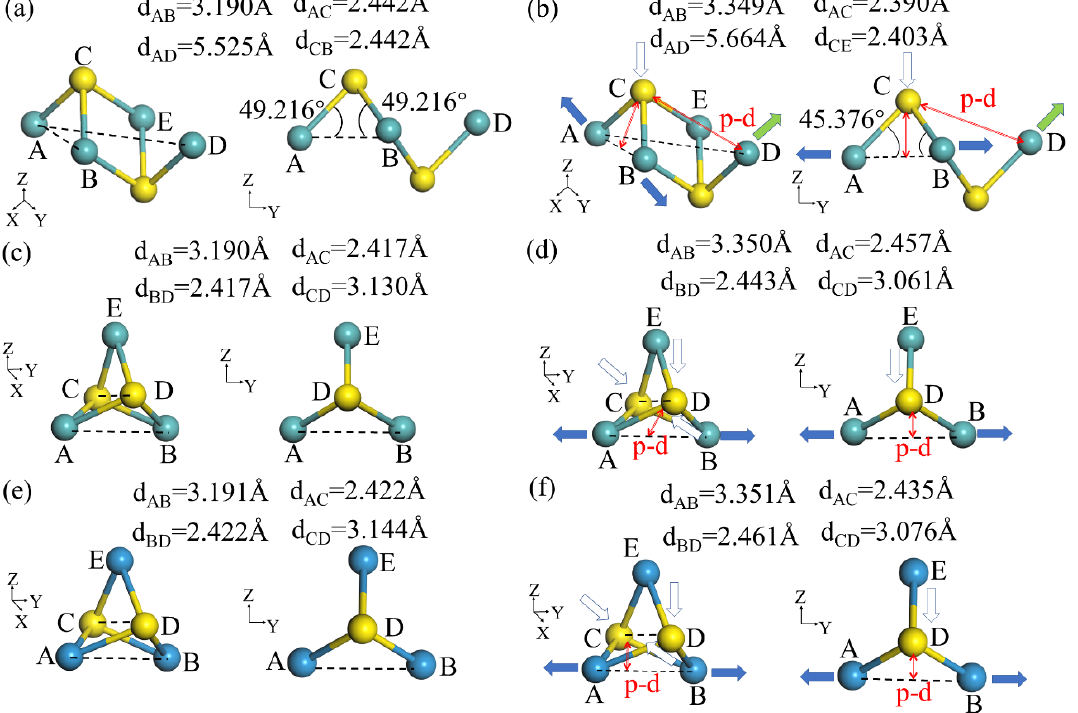
Figure 5. ( a ) Structure of single-layer MoS 2 (space group R3m) without strain. ( b ) Structure of single-layer MoS 2 (space group R3m) after strain is applied. The force is applied along the Y -axis. The red arrow indicates p-d orbital interaction and the green arrow shows the result of the final movement of MoS 2 . ( c ) Structure of single-layer MoS 2 (space group P6 3 /mmc) without strain. ( d ) Structure of single-layer MoS 2 (space group P6 3 /mmc) after strain is applied. ( e ) Structure of single-layer WS 2 (space group R3m) without strain. ( f ) Structure of single-layer WS 2 (space group R3m) after strain is applied.